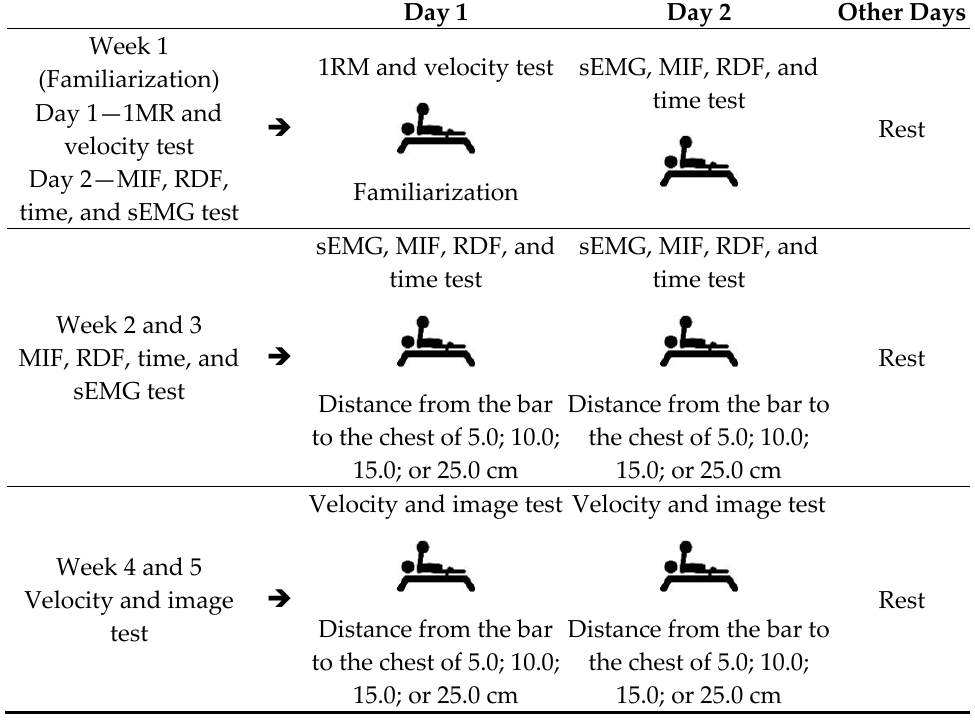
Figure 1. Experimental design: Weekly test schedule. Legend: 1RM: 1 Repetition Maximum; SEMG: surface electromyography; MIF: Maximum Isocmetric Force; RFD: Rate of Force Development; Time: Time to MIF.